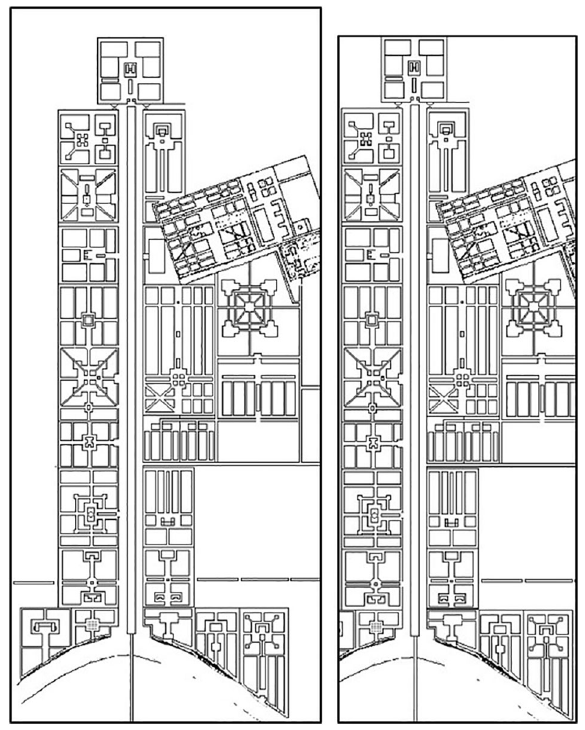
Fig. 9 Isfahan map cropped in two different ways. The fi rst image (left) is the original plan used for analysis, with D = 1.7. The second (right) the cropped version to limit the amount of background space included in the fractal analysis, which yields a higher D =